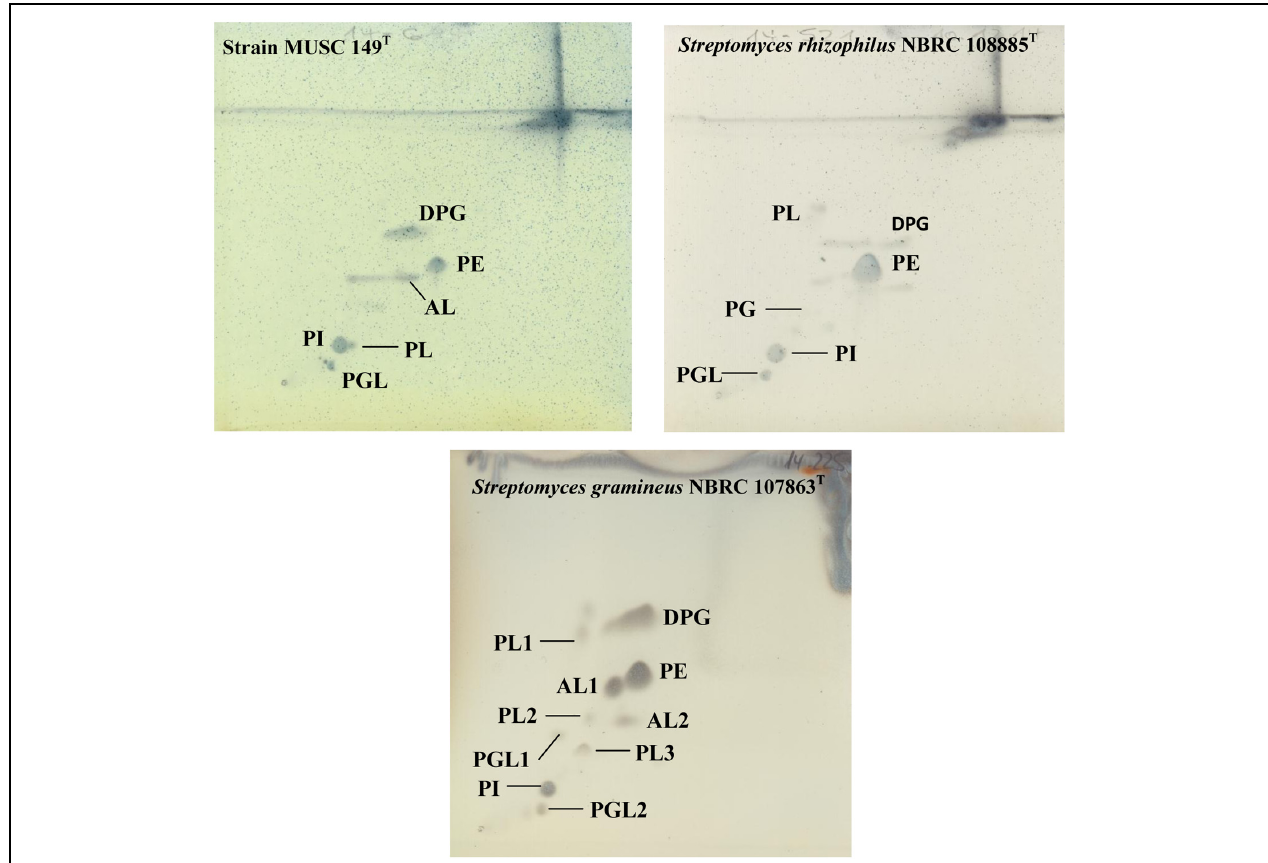
FIGURE 3 | Two dimensional total lipid profile of strain MUSC 149 T , S. rhizophilus NBRC 108885 T and S. gramineus NBRC 107863 T . AL, Aminolipid; DPG, Diphosphatidylglycerol; PL, Phospholipid; PI, Phosphatidylinositol; PE, Phosphatidylethanolamine; PG, Phosphatidylglycerol; PGL, Phosphoglycolipid.